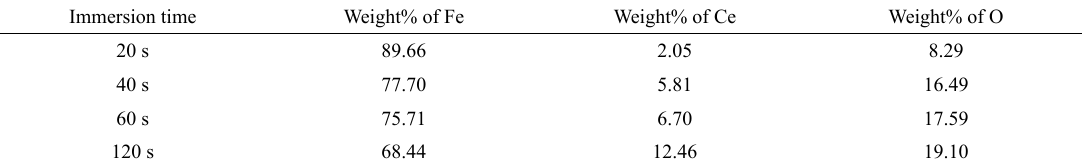
Table 5. EDX analysis of cerium conversion coatings obtained after different immersion times. Immersion